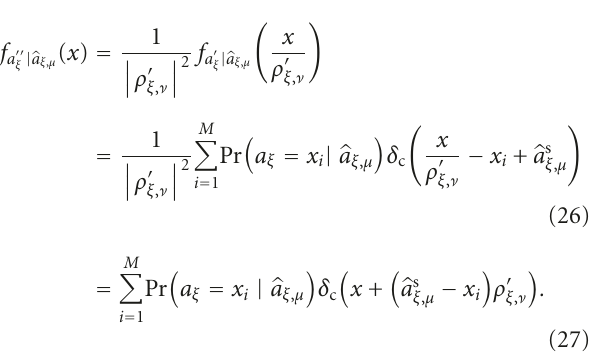
Figure 1: Pdf of ISI, MAI, and noise with Gaussian assumption for ( E b / N 0 ) = 25 dB. 10log 10